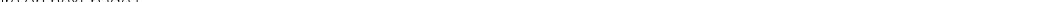
figure on next Fig. 4 Example earthquake signal observations. a A moderate-sized (M2.9) event on January 27, 2020, at 16:23:31.8 (UT). The observed strain at three DAS channels (top) and the horizontal velocity seismograms at two DONET2 stations (bottom) are shown; all of the waveforms have been bandpass filtered at 2–16 Hz. b A very small (M1.1) event on January 30, 2020, at 00:20:25.7 (UT). The observed strain at three DAS channels (top) and the horizontal velocity seismograms at two Hi-net stations (bottom) are shown; all of the waveforms have been bandpass filtered at 2–16 Hz. velocity seismograms at a DONET station (MRG29) and F-net station (UMJF) (bottom) are shown; all of the waveforms have been bandpass filtered at 0.01–0.1 Hz. All of the velocity data are shown relative to the origin time of the event. d DAS records for all of the channels and the earthquake in a. The amplitudes are presented as the logarithm of the normalized absolute amplitude of the strain rate, and have been bandpass filtered at 2–8